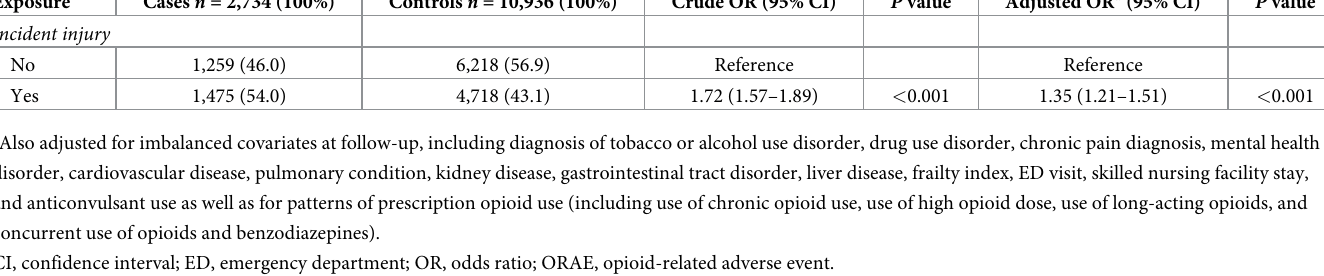
Table 2. Association between incident injury after prescription opioid initiation and subsequent risk of ORAE AU : AbbreviationlistshavebeencompiledforthoseusedinTables 2 (cid:0) 4 : Pleaseverifythatallentriesarecorrect : .